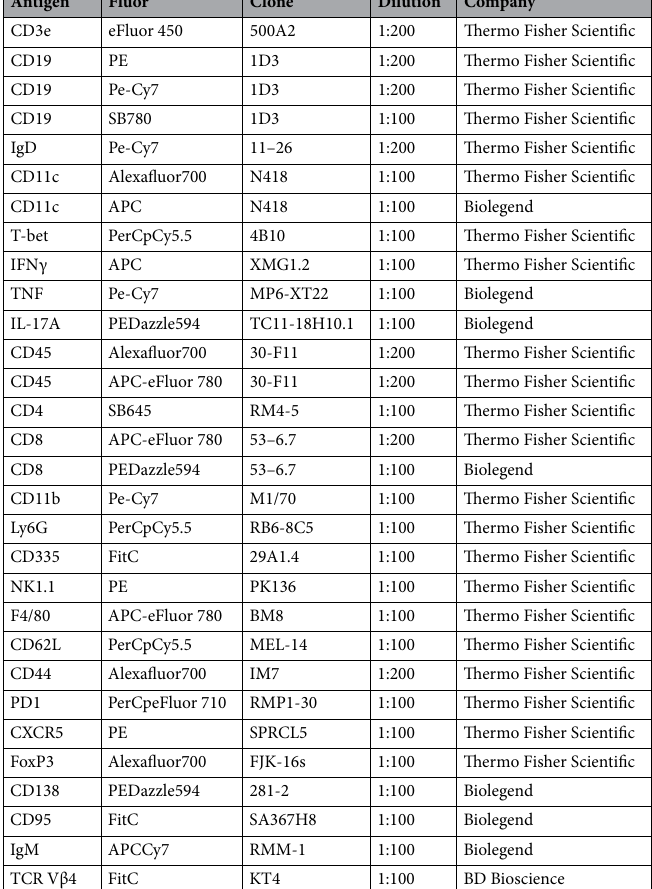
Table 1. Flow cytometry